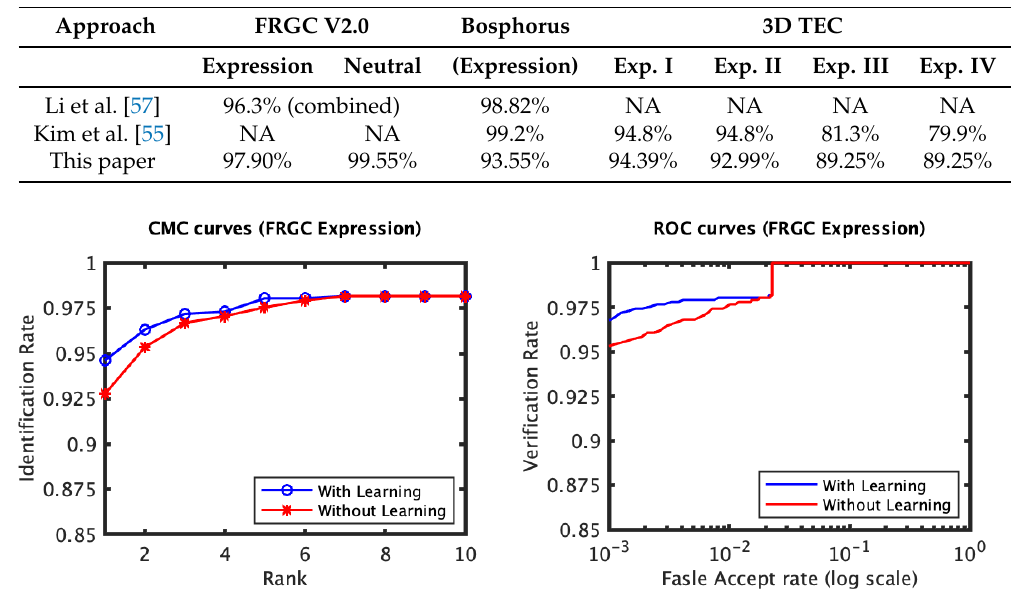
Figure 9. The CMC and ROC curves of the FRGC facial scans under expression using local 3D PCA